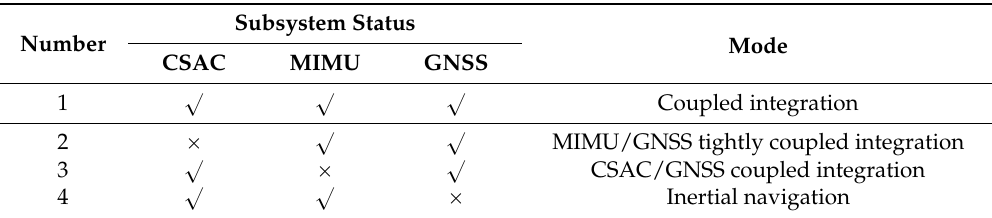
Table 1. Degradations of the coupled